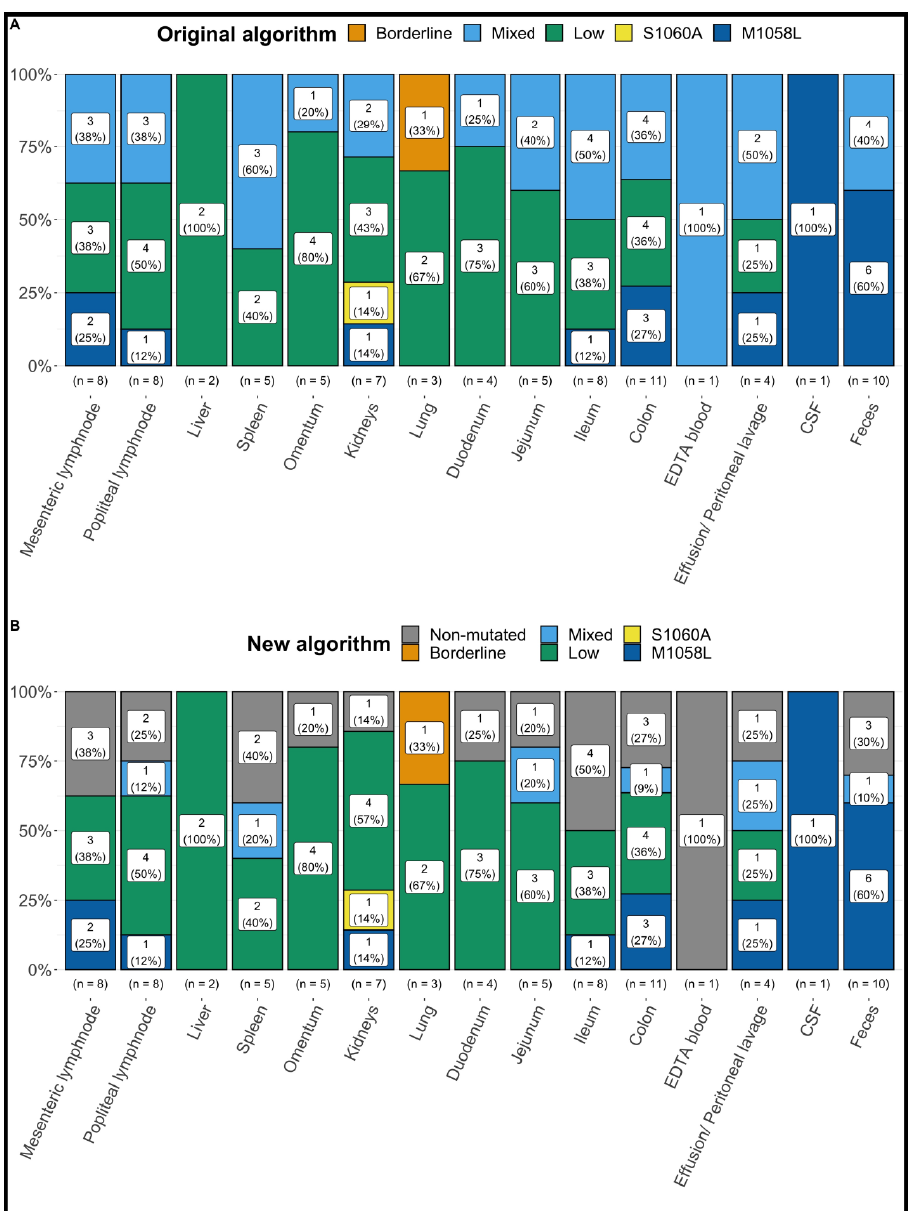
Figure 1. Summary of the results of the commercial real-time feline coronavirus (FCoV) 7b gene and spike (S) gene mutation reverse transcription polymerase chain reactions (RT-qPCR) following the original algorithm (1A) and the new algorithm (1B) in all tissue, fluid, and fecal samples from the 21 cats positive for FCoV RNA in at least one sample. M1058L = positive FCoV S gene mutation RT-qPCR detecting mutation in nucleotide 23,531, corresponding to amino acid